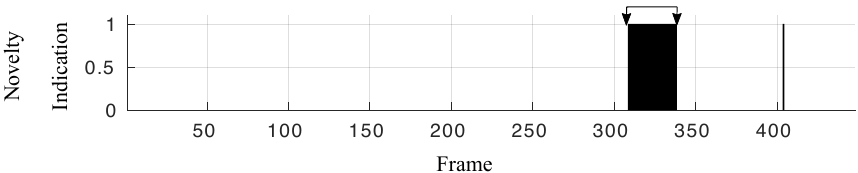
Figure 11. Illustration of the visual exploration and inspection task on dataset D-3 to detect the black tire as the novel object. In the exploration phase, the SECoS detector constructs a model of the environment with the person. In the inspection phase, the detector uses this model to detect the black tire.